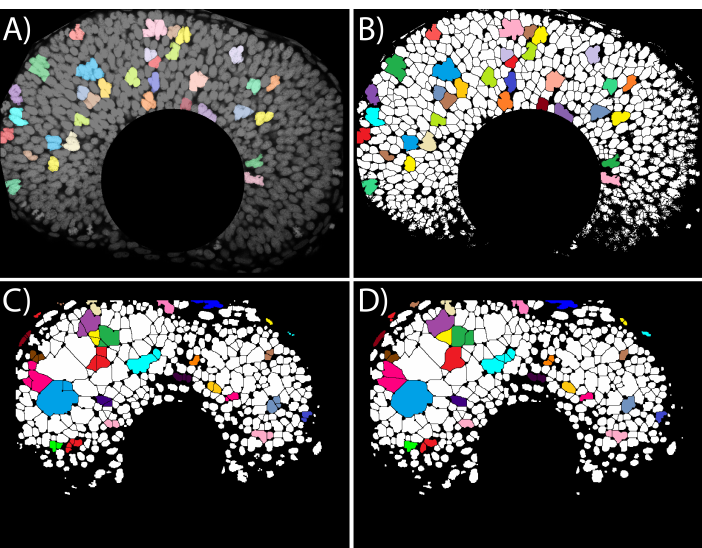
Figure 2. Automated segmentation of images from developing zebrafish retina. ( A ) Section of a developing zebrafish retina at 44 h post fertilization stained with nuclear marker Topro3 (see methods section). ( B ) Segmentation of the same section using Fiji base algorithms (auto-threshold + watershed). Individual objects not correctly identified are highlighted with different colors. ( C ) Image segmentation of a section of a developing zebrafish retina at 44 HPF (using FIJI base algorithms) following the pipeline: (1) automatic thresholding; (2) binary morphological opening (open function); (3) binary morphological closure (close function); (4) watershed algorithm (watershed function). ( D ) Segmentation using the exact same filters, with the only difference being that the order between closing and opening filters is reversed. Nuclei segmented differently by these two very similar pipelines are highlighted in colors.